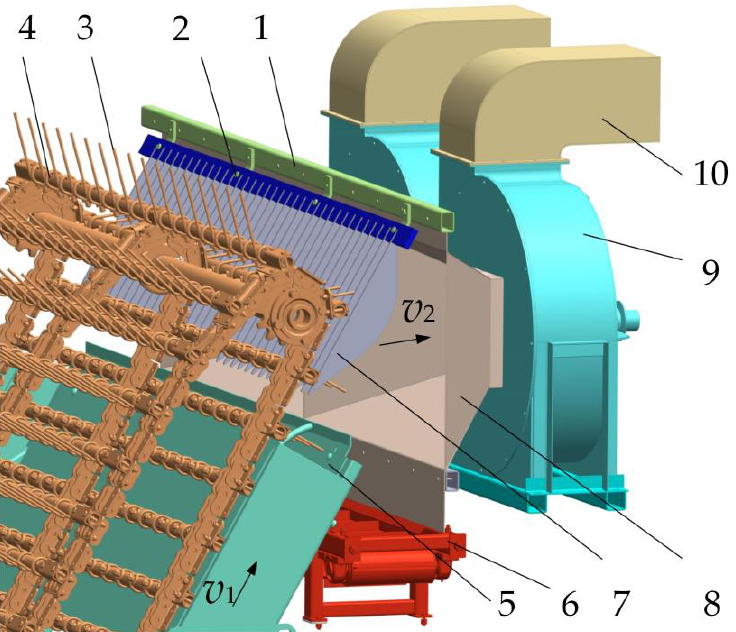
Figure 2. Schematic diagram of the structure of the SIRD. Note: 1 — Supporting beam; 2 — Mounting plate of FTP; 3 — Spring teeth; 4 — FCCH; 5 — Supporting plate; 6 — Impurity conveying mechanism; 7 — FTP; 8 — Wind-collecting hood; 9 — Centrifugal fan; 10 — Film conveying pipe.